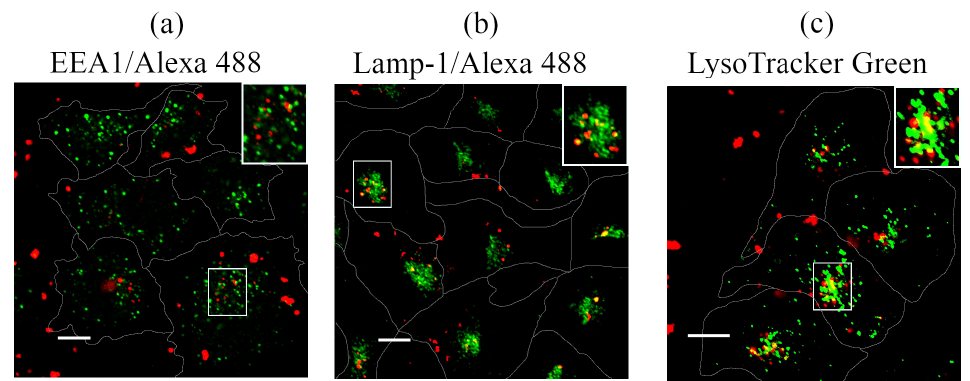
Figure 6. Analysis of the association of QDs with markers of the endocytic pathway. Confocal images of HeLa cells after incubation with QDs (50 nm) for 4 h ( a ) and 24 h ( b , c ). Cells were fixed and immunostained with EEA1/Alexa 488 ( a ) or Lamp-1/Alexa 488 ( b ) antibodies before confocal microscopy. Live cells stained with LysoTracker Green DND-26 ( c ) for 20 min before confocal imaging. The insets represent enlarged views (3×) of the corresponding boxed region of the cell. Photoluminescence of QDs excited at 405 nm and recorded in the range of 520–620 nm. Alexa 488/LysoTracker Green fluorescence was excited at 488 nm and recorded in the 500–550 nm range. Scale bars 10 µ